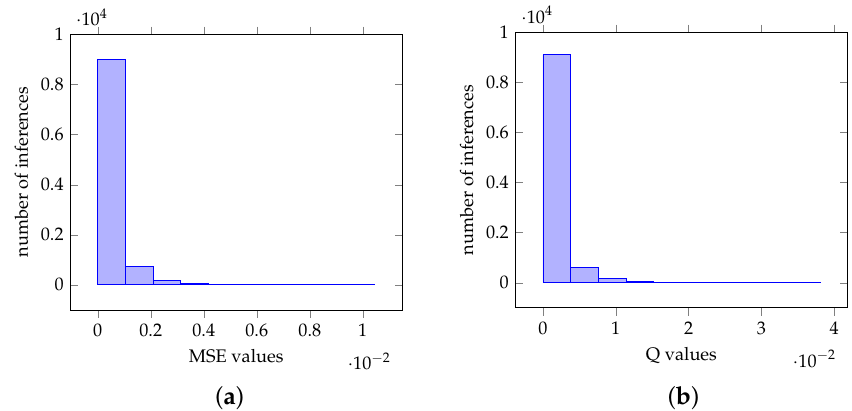
Figure 10. Values obtained from imagenet image MobileNetV2 net classification for 1000 classes. ( a ) Histogram of the MSE values. ( b ) Histogram of the Q (cid:48) values.